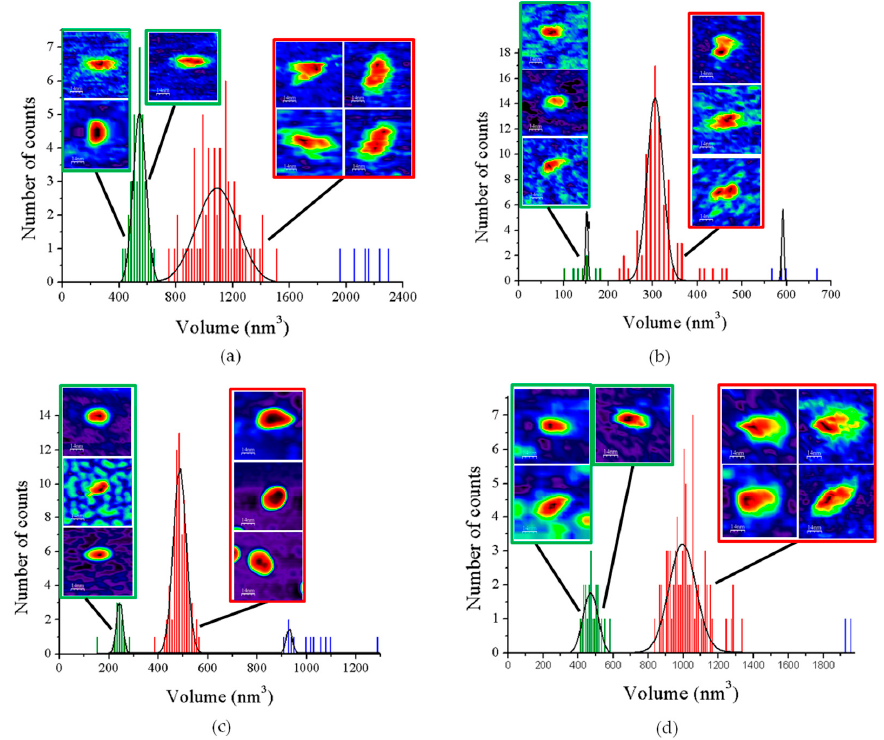
Figure 2. Volume frequency histograms for the features found in AFM images of native proteins. ( a ) GvFTTR; ( b ) CaFFTR2; ( c ) GvDDOR; and ( d ) GvFFTR_ Δ tail samples. Green, red, and blue data correspond to features assigned as subpopulations 1, 2, and 3, respectively. Besides the main subpopulations identified in each histogram, 2D images of the corresponding most representative features are shown. The sample size is defined as 100 (n = 100) for the histogram analysis. Scan sizes for all the images are 70 nm × 70 nm. The numerical ranges of “x” and “y” axes have been adjusted to the values of the histograms in each case. For clarity, the Z-scale of 2D features (differing in each case, but shown in subsequent Figures and Supplementary material Figures) and the 2D images for subpopulation 3 (which are in very small proportions) are not shown. See Figure A2 for 2D images of subpopulation 3.